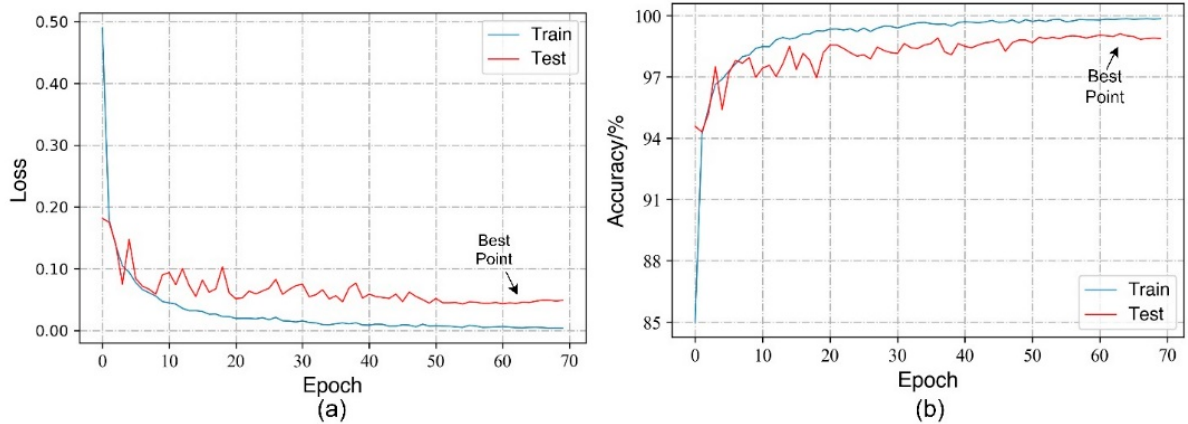
Figure 10. Convergence comparison: ( a ) loss; ( b ) accuracy. The confusion matrix of the final ALD identification results is depicted in Figure 11.